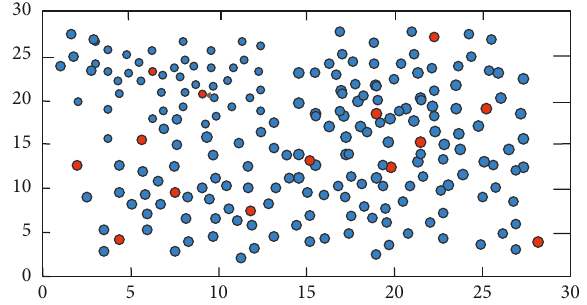
Figure 4: Outliers detected by the algorithm before the improvement.